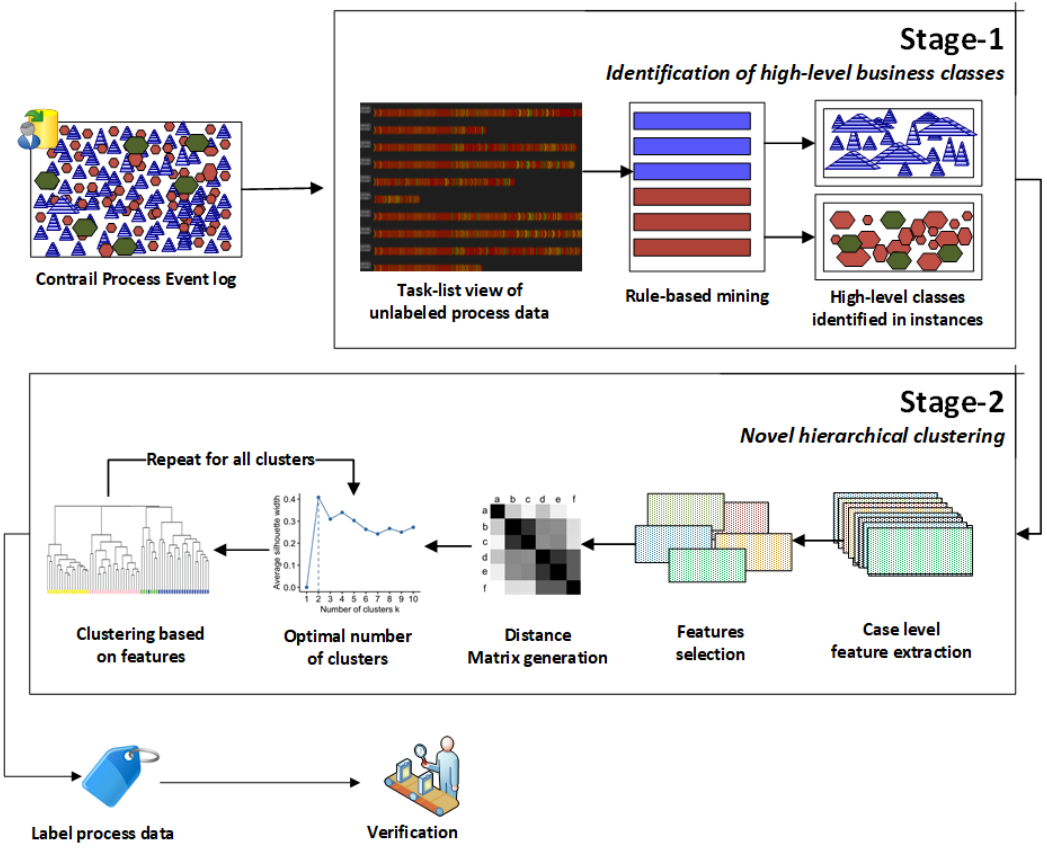
Figure 5. Multi-stage framework for business process log